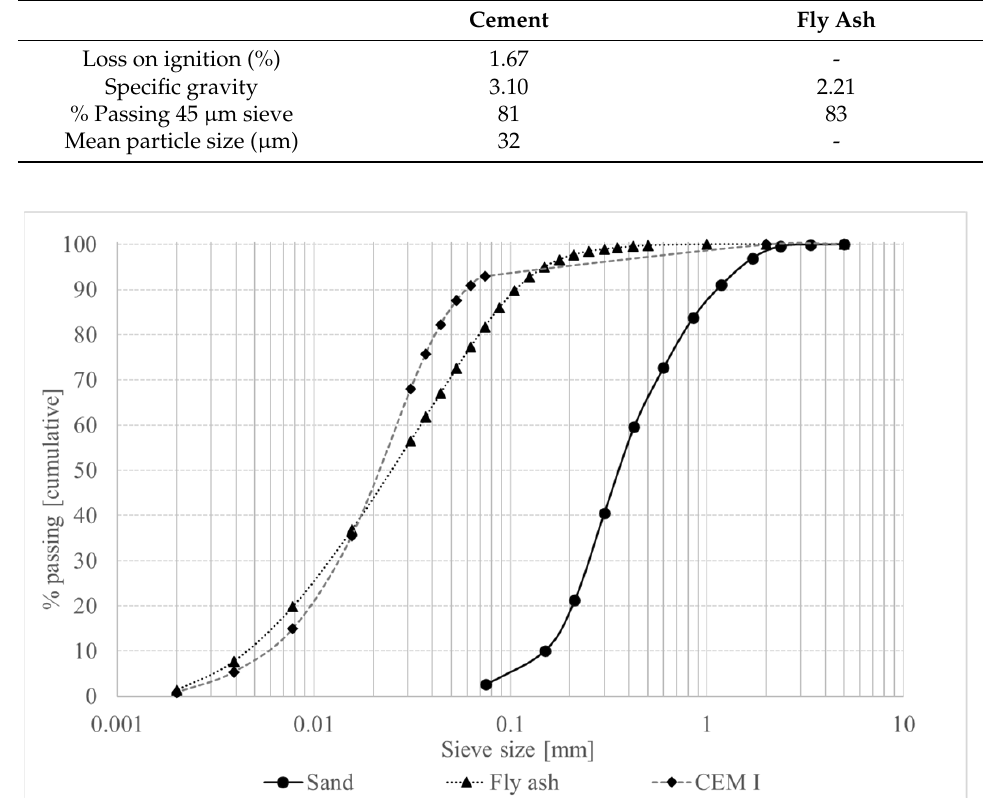
Figure 1. Grain size